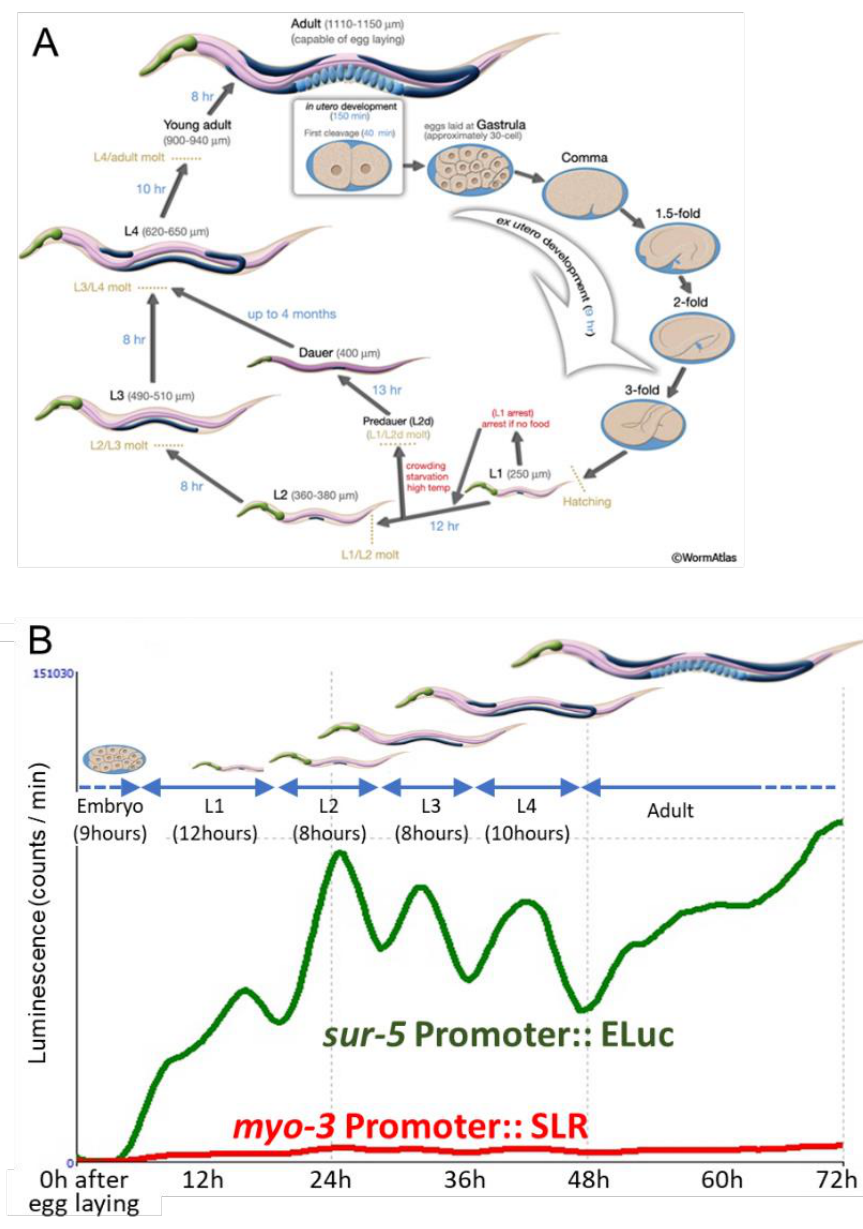
Figure 2. ( A ) The life cycle of C. elegans development (wormatlas; Altun, Z.F., Herndon, L.A., Wolkow, C.A., Crocker, C., Lints, R. and Hall, D.H. (ed.s) 2002–2020. http://www.wormatlas.org). ( B ) A representative trace of two luminescent signal changes. Pictures of each larval developmental stage are modified from A and shown above the trace.